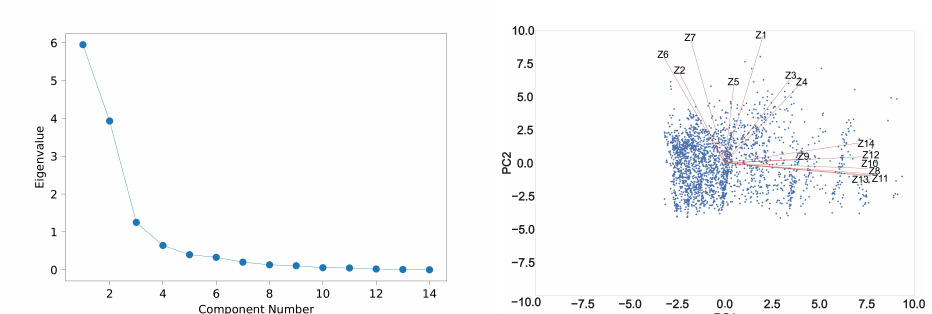
Figure 6. Left plot: scree Plot. Right plot: biplot.